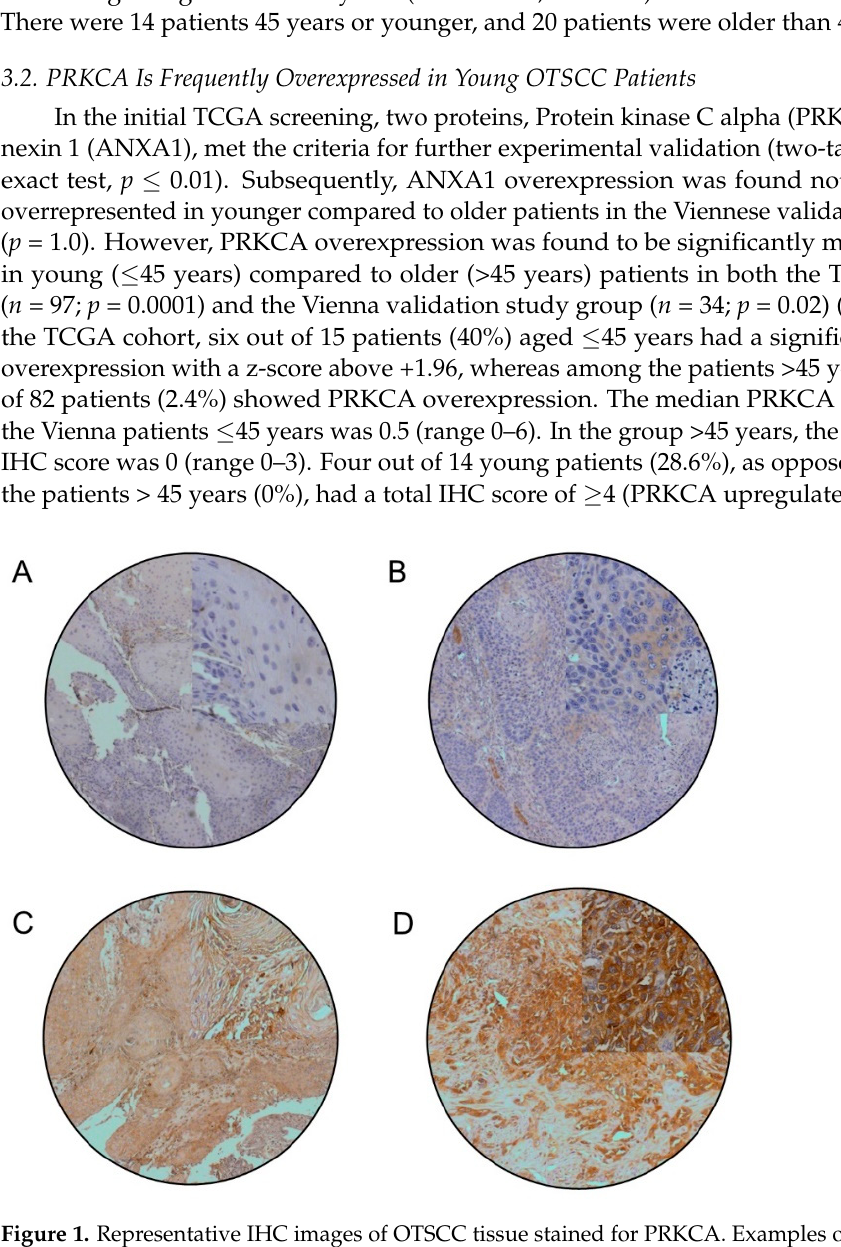
Figure 1. Representative IHC images of OTSCC tissue stained for PRKCA. Examples of OTSCC with ( A ) no, ( B ) weak focal, ( C ) moderate and ( D ) strong PRKCA immunoreactivity (10×). Areas in the upper right quadrants were enlarged to 40×.